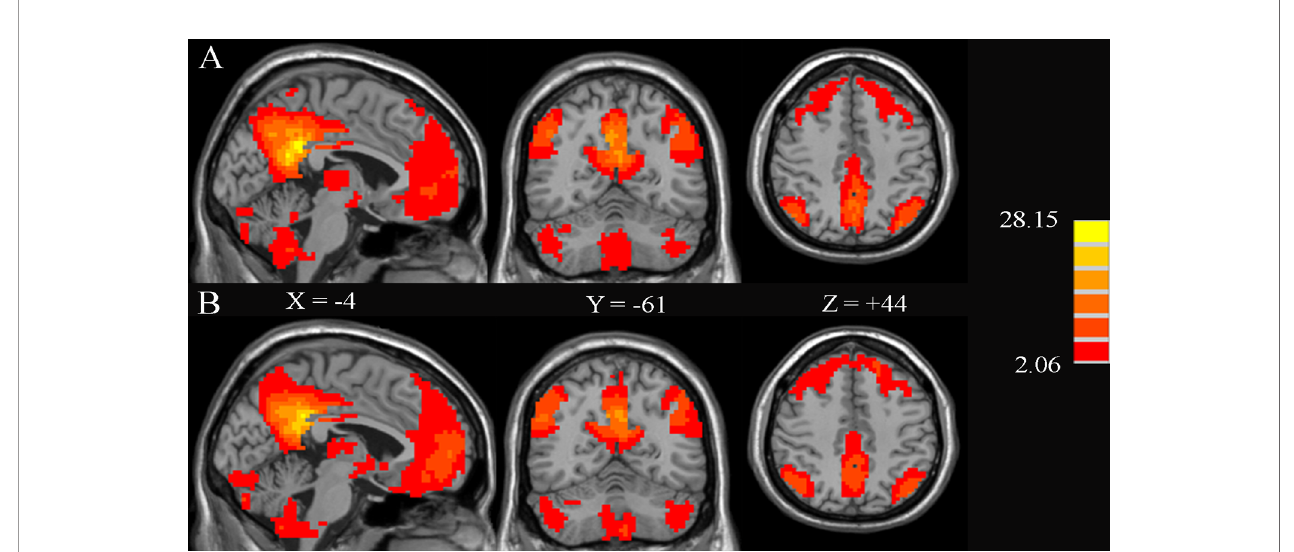
FIGURE 3 | Signi fi cant brain functional connectivity with the posterior cingulate cortex (PCC) using one-sample t -test in healthy controls (A) and type 2 diabetes patients without cognitive and microvascular complications (B) . AlphaSim-corrected threshold of p < 0.05. The values of X , Y , and Z represent the MNI coordinates of the sagittal, coronal, and axial positions,